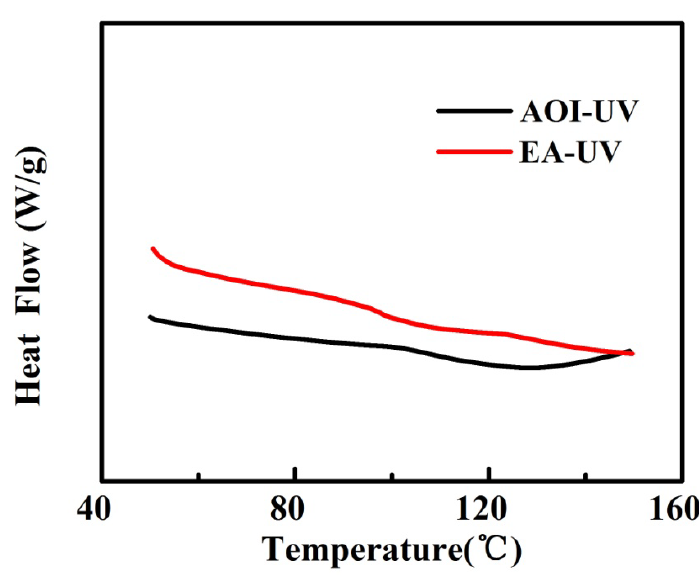
Figure 7. DSC curves of high refractive index UV cured film.